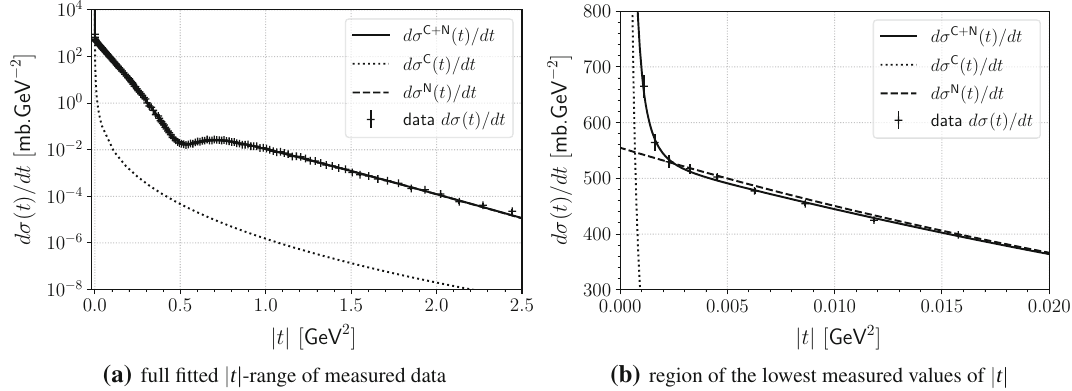
Fig. 7 Eikonal model of Coulomb-hadronic interaction fitted to measured elastic pp differential cross section at energy of 8 TeV in the interval | t | ∈ (cid:7) 0 . 000741 , 2 . 5 ) GeV 2 corresponding to Fit 1, i.e., central picture of elastic pp scattering. Fit 2 leading to peripheral picture of elastic scattering gives similar